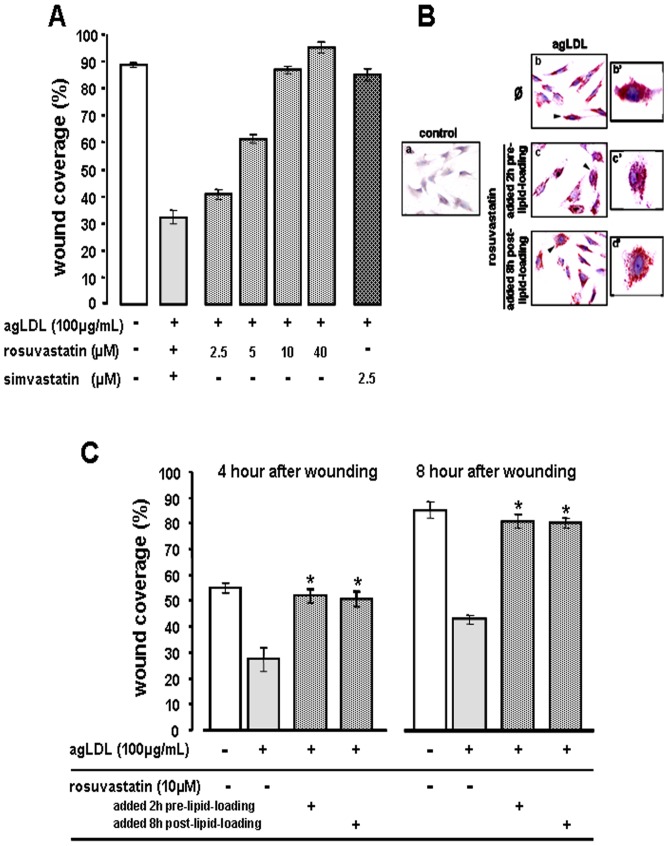
Dose-dependent response to rosuvastatin in cell migration of VSMC exposed to LDL.Bar diagram for (A) dose dependent effect of rosuvastatin (2.5–40 µM) in wound regeneration by VSMC treated without/with agLDL 8 hours after wounding. P<0.01 (Kruskal-Wallis test) for rosuvastatin dose-response effect and P<0.001 for simvastatin effect (Man-Whitney test) vs agLDL-group. (B and C) VSMC were treated without or with rosuvastatin (10 µM) since 2 hours before (2 h-pre LDL) or 8 hours after (8 h-post LDL) adding agLDL to the cell culture medium. B: staining with Herxheimer reagent (Sudan III and Sudan IV) (red colour) as a control for intra-cellular accumulation of lipids. Ø refers to agLDL-VSMC non treated with rosuvastatin. C: Results shown as mean±SEM (% of wounded area at time 0) refer % of the wound regenerated area 4 and 8 hours after wounding (n=4 independent experiments); * p<0.05 compared to the agLDL-group (Man-Whitney test).